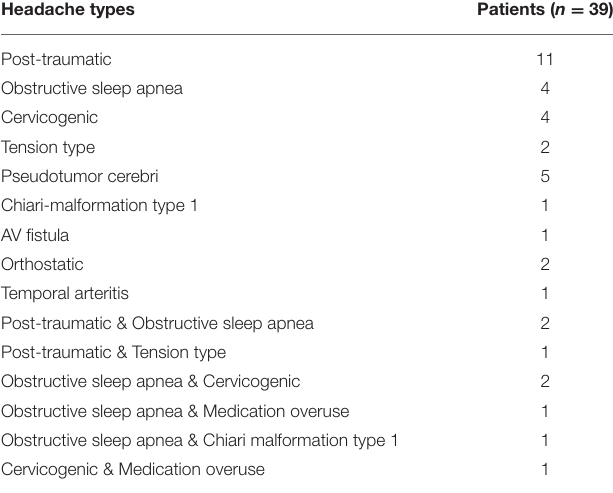
TABLE 2 | Headache